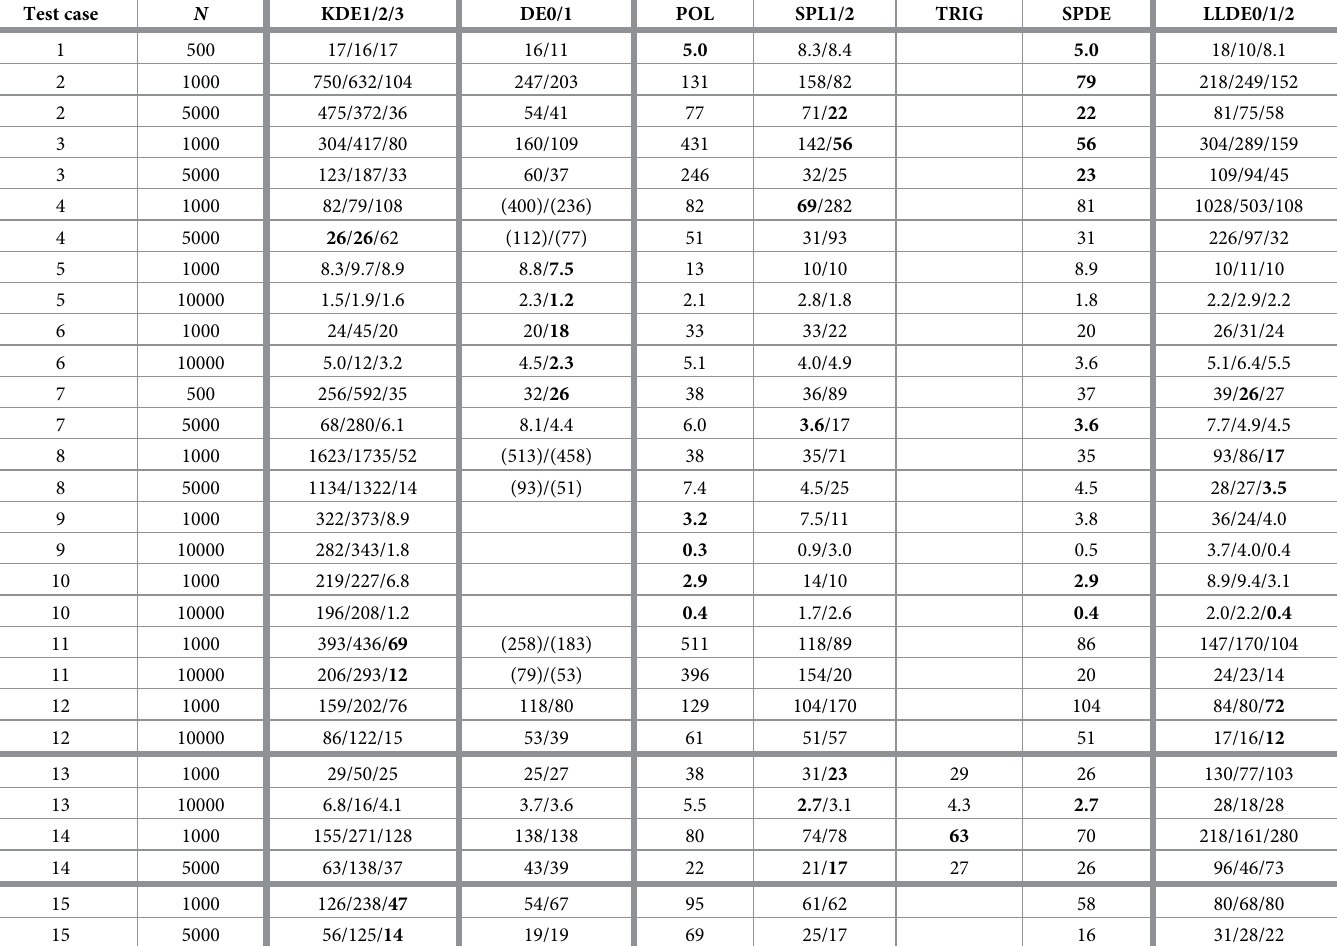
Table 4. Mean integrated squared error (scaled by 10 4 ) estimated as the average over 100 realisations for the test cases in Table 3. For test cases 14 and 15, the semi- parametric estimators allow for logarithmic boundary terms at any boundary point. The best method is indicated in bold. For test cases 9 and 10, the diffusion estimators are unstable; for test cases 4, 8 and 11, they give reasonable density estimates in most realisations but are unstable in some realisations. See S3 Appendix for further